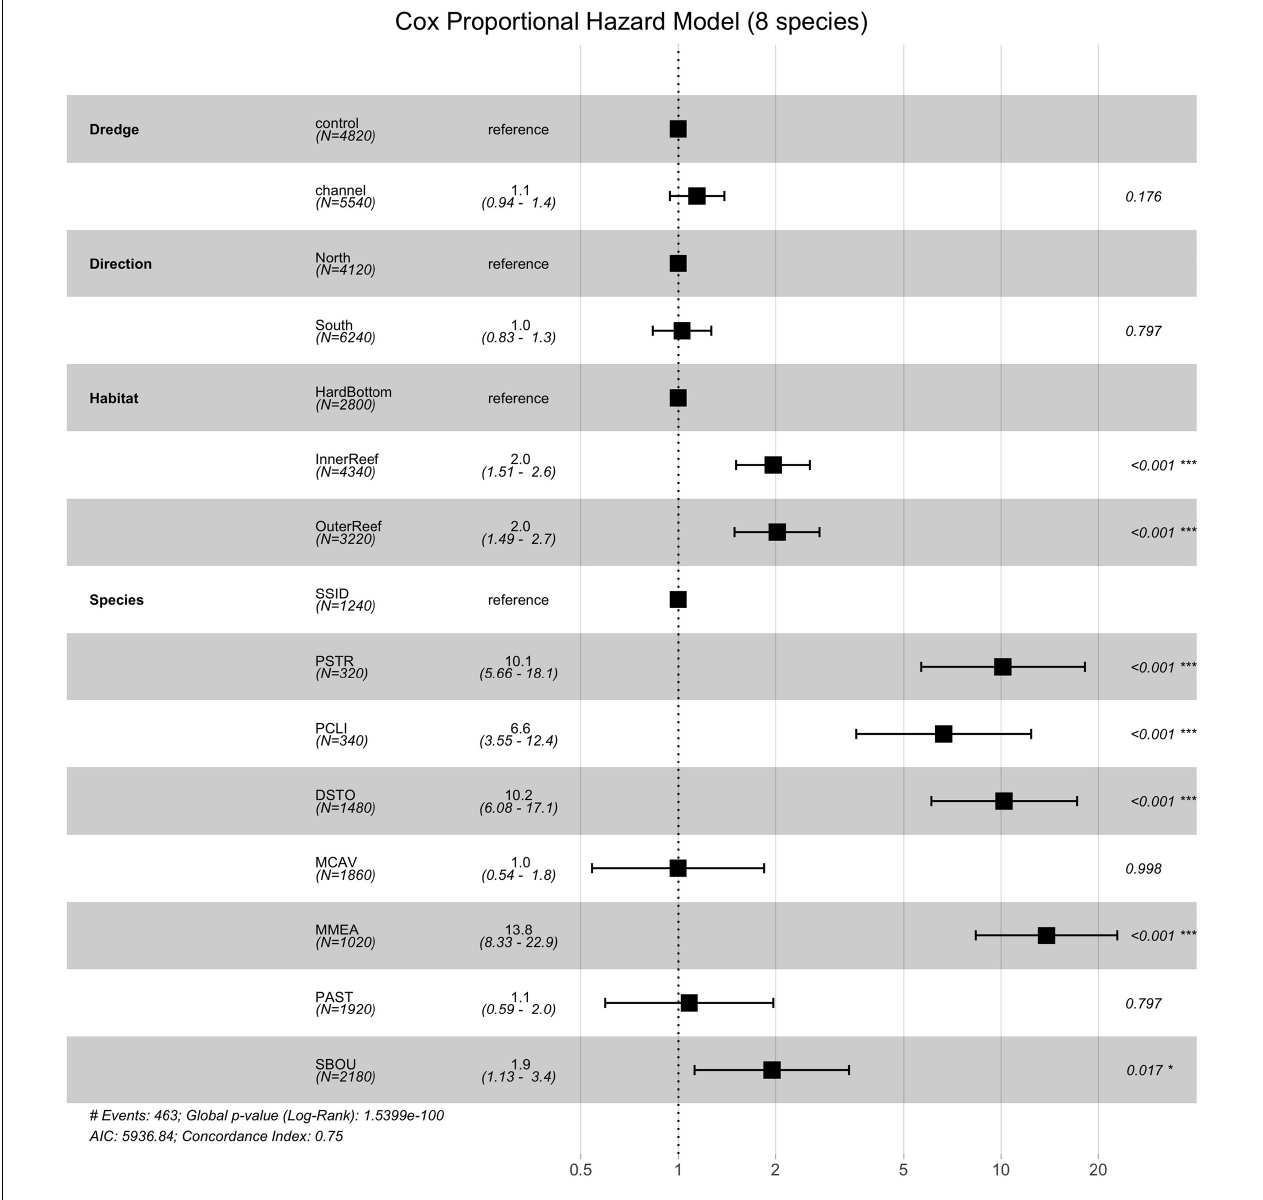
FIGURE 5 | Cox-proportional hazard model comparing the effects of dredge (control vs. channel), habitat (hardbottom vs. inner reef and outer reef), direction (north vs. south) and species across the top eight coral species in the dataset that experienced at least some mortality. In the Cox-proportional hazard model the median hazard ratios (HR) +/– the standard errors are shown along with the p -values (far right) showing the pairwise comparisons between the reference level and the comparison (e.g., control as the reference for dredging compared to